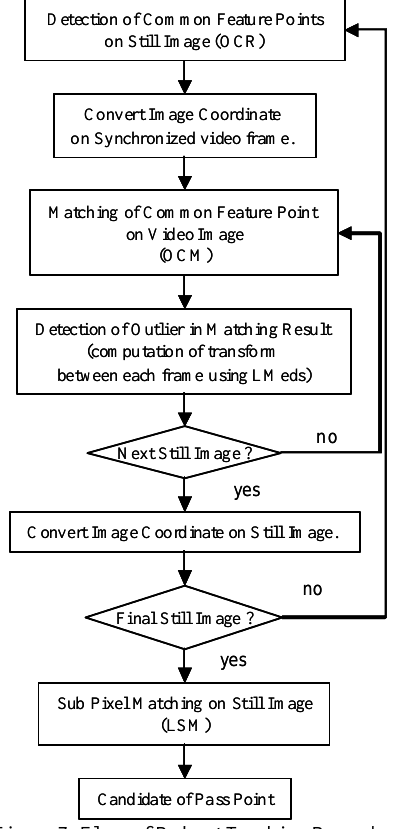
Figure 7. Flow of Robust Tracking Procedure